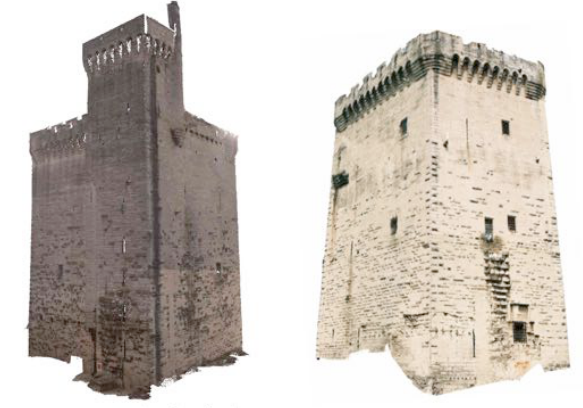
Figure 1. The developed on-line database for archiving and sharing all the documentary sources related to the Avignon’s Bridge